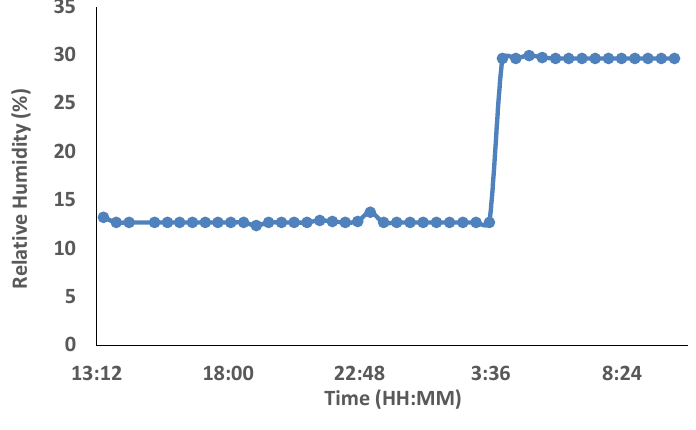
Figure 21. Relative Humidity.